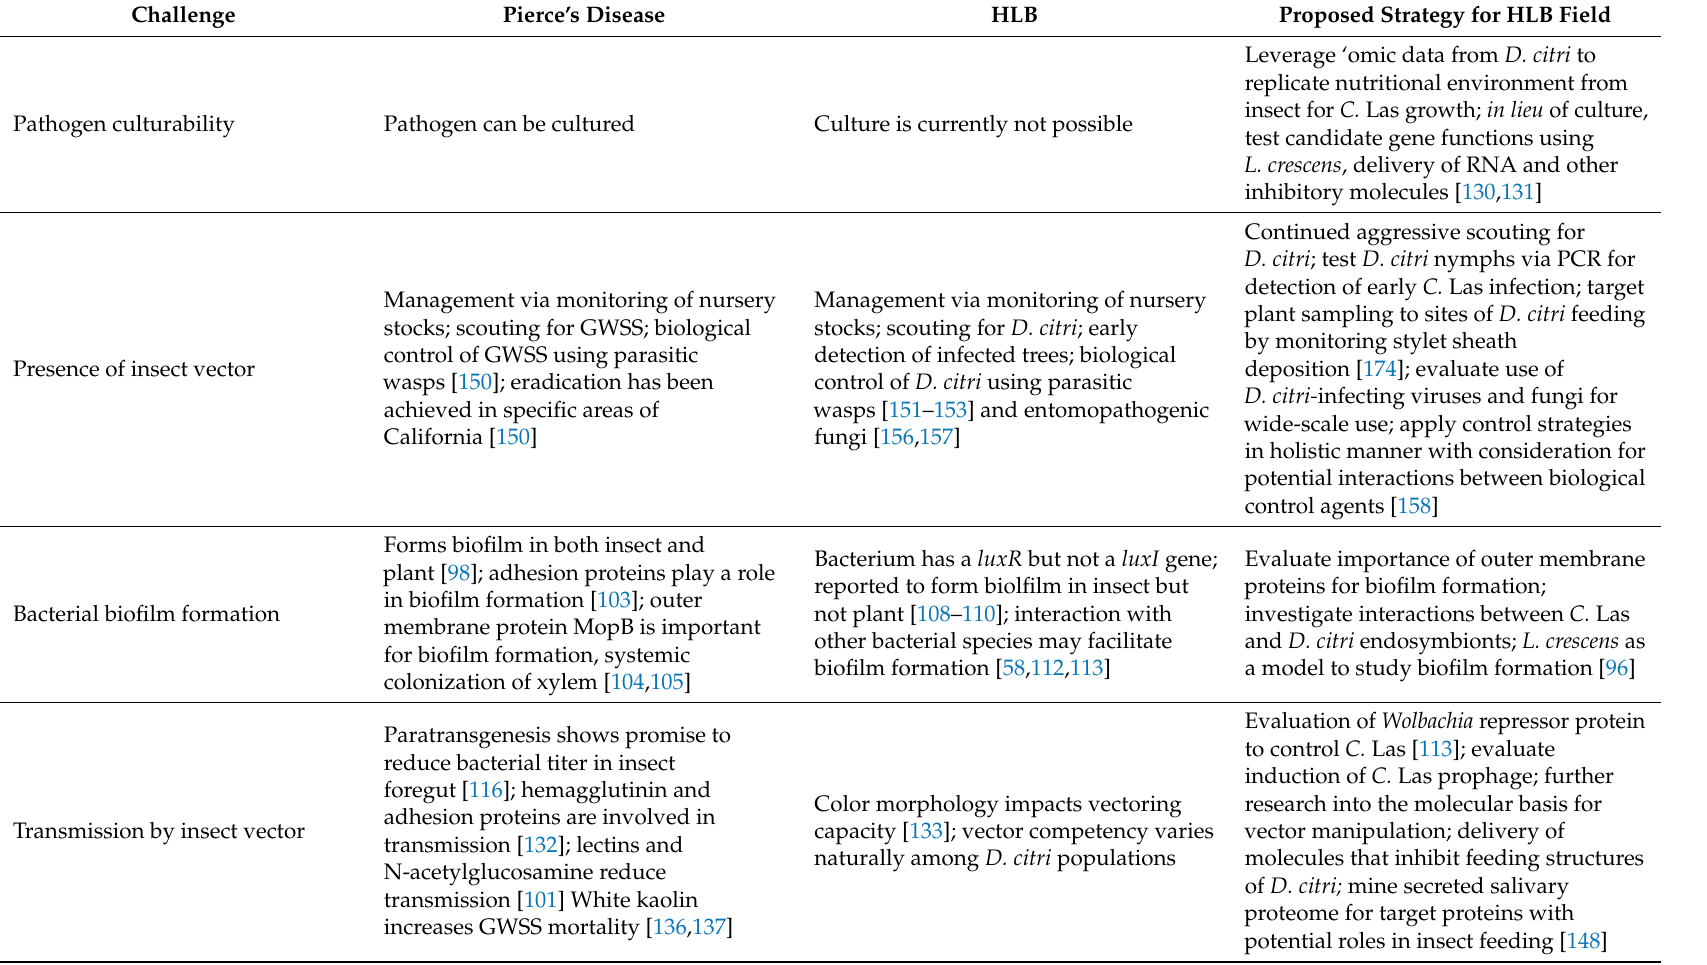
Table 4. Summary and proposed strategies for HLB